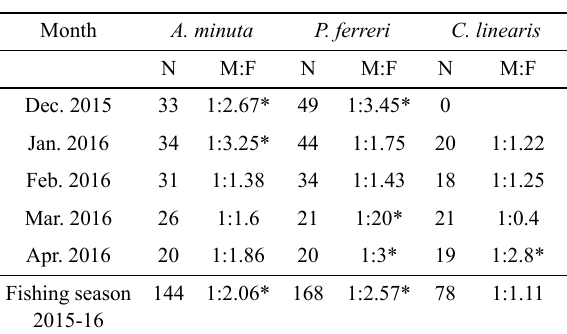
Table 4. – Sex ratio throughout the spawning season of A. minuta , P. ferreri and C. linearis . * p ˂ 0.05.